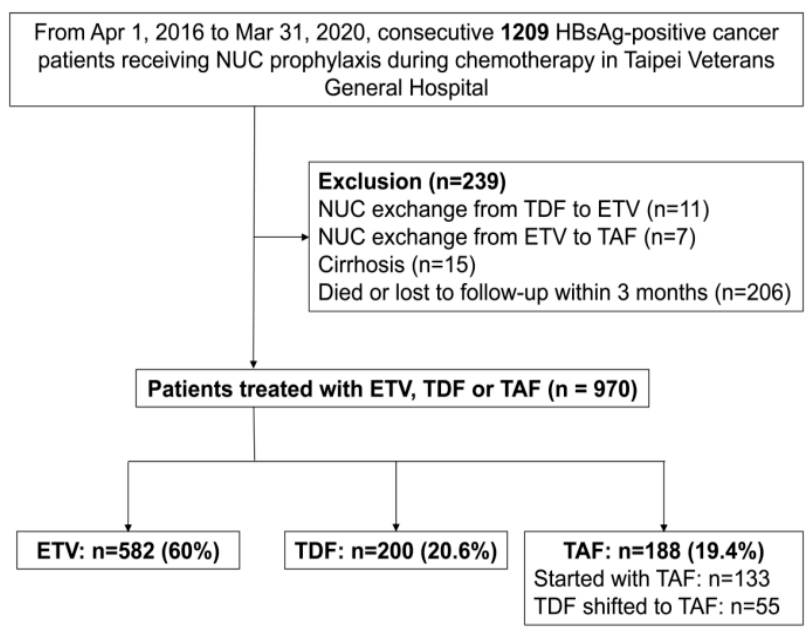
Figure 1. Screening, enrollment and grouping of patients. Table 1. Baseline characteristics of the 970 HBV-infected cancer patients receiving chemotherapy.